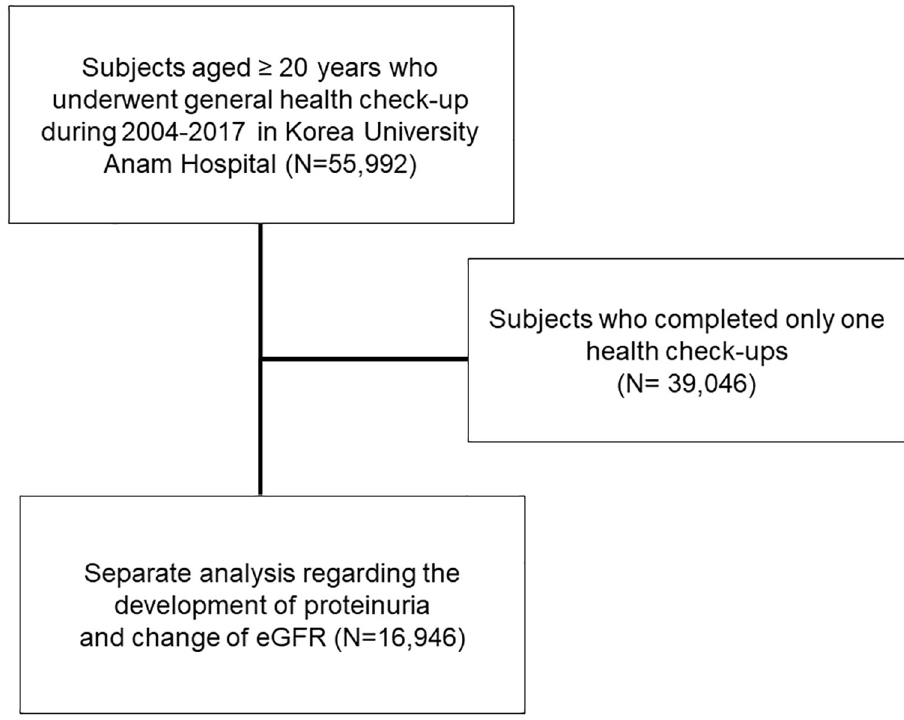
Fig 1. Selection of study